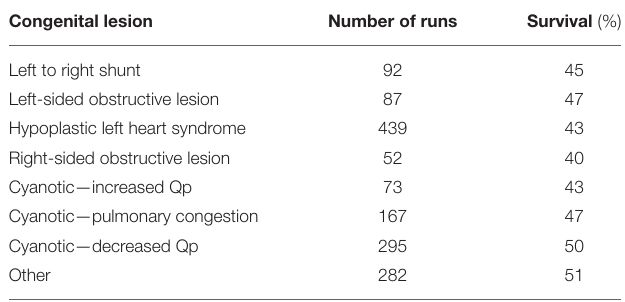
TABLE 6 | Hospital survival of neonatal cardiac ECMO by congenital